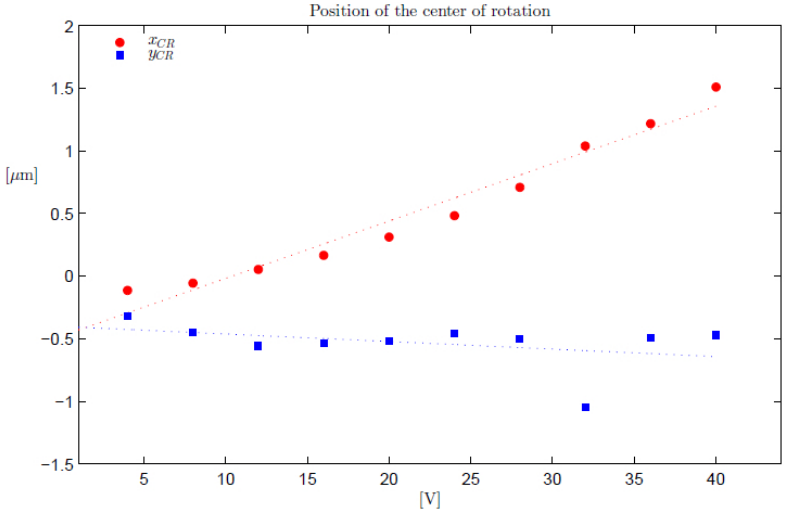
Figure 6. Cartesian coordinates in R { O , x , y , z } of the center of rotation for the set of the applied